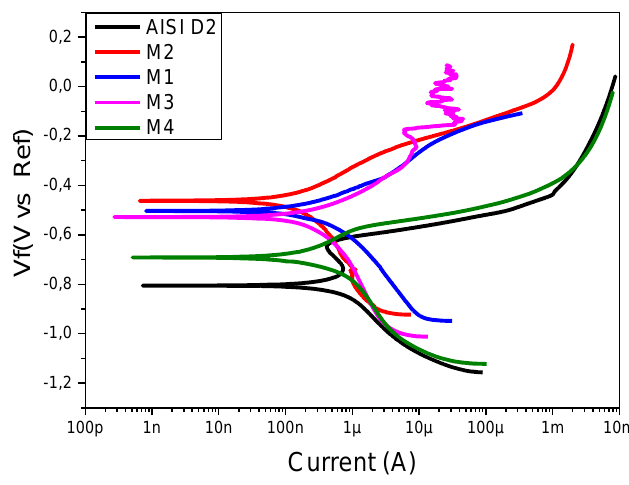
Figure 9. Linear polarization curves for carbide coatings. Table 4. Parameters obtained from the linear polarization curves for each of the coatings: current corrosion (Icor), corrosion potential (Ecor), and the anodic ( β a) and cathodic ( β c) Tafel slopes. Sample Icorr